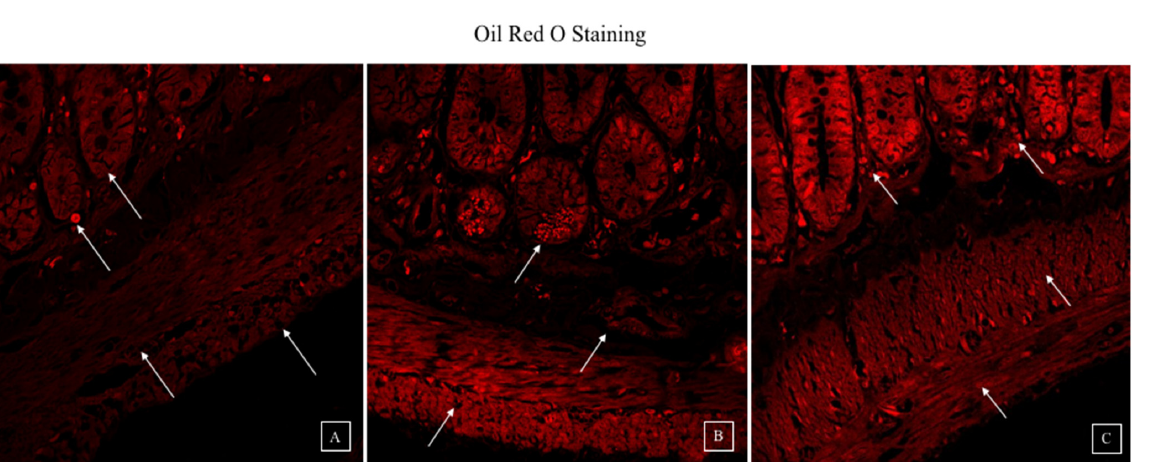
Figure 5. The influence of the synbiotic on the reduction of ethanol-mediated inflammation in the colonic epithelium as assessed by histopathological changes. The colon of a rat in its raw state (100×). These are the microscopic images: ( A ) control rats ( B ) rats fed 100 mM ethanol in increasing amounts ( C ) rats given ethanol and synbiotic (10 9 CFU/day L. rhamnosus and 200 mg/kg AGE). The lipid staining of the colon bilayer with Oil red O dye revealed the development of lipid droplets associated with Lieberkühn crypts and an atypical shape indicated by the disruption of TJs in the ethanol group. As illustrated in Figure 6, the synbiotic intervention reduced lipogenesis and improved the epithelial barrier compared to the control group.